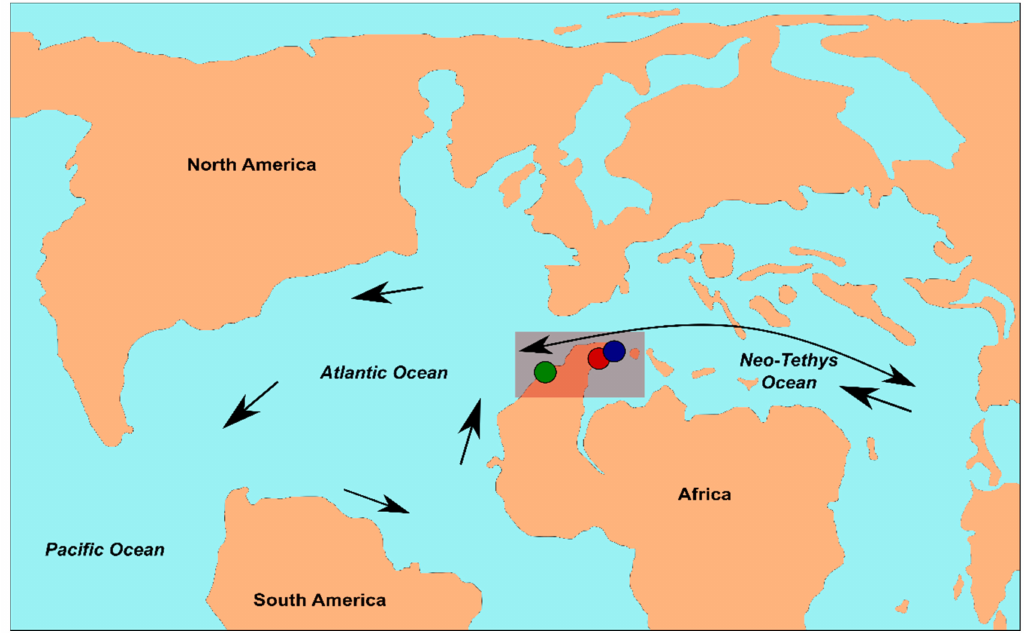
Figure 10. Paleogeographic schema at Paleocene–Eocene time displaying the main water circulation along the Africa paleomargin and the position of studied deposits. Modified after